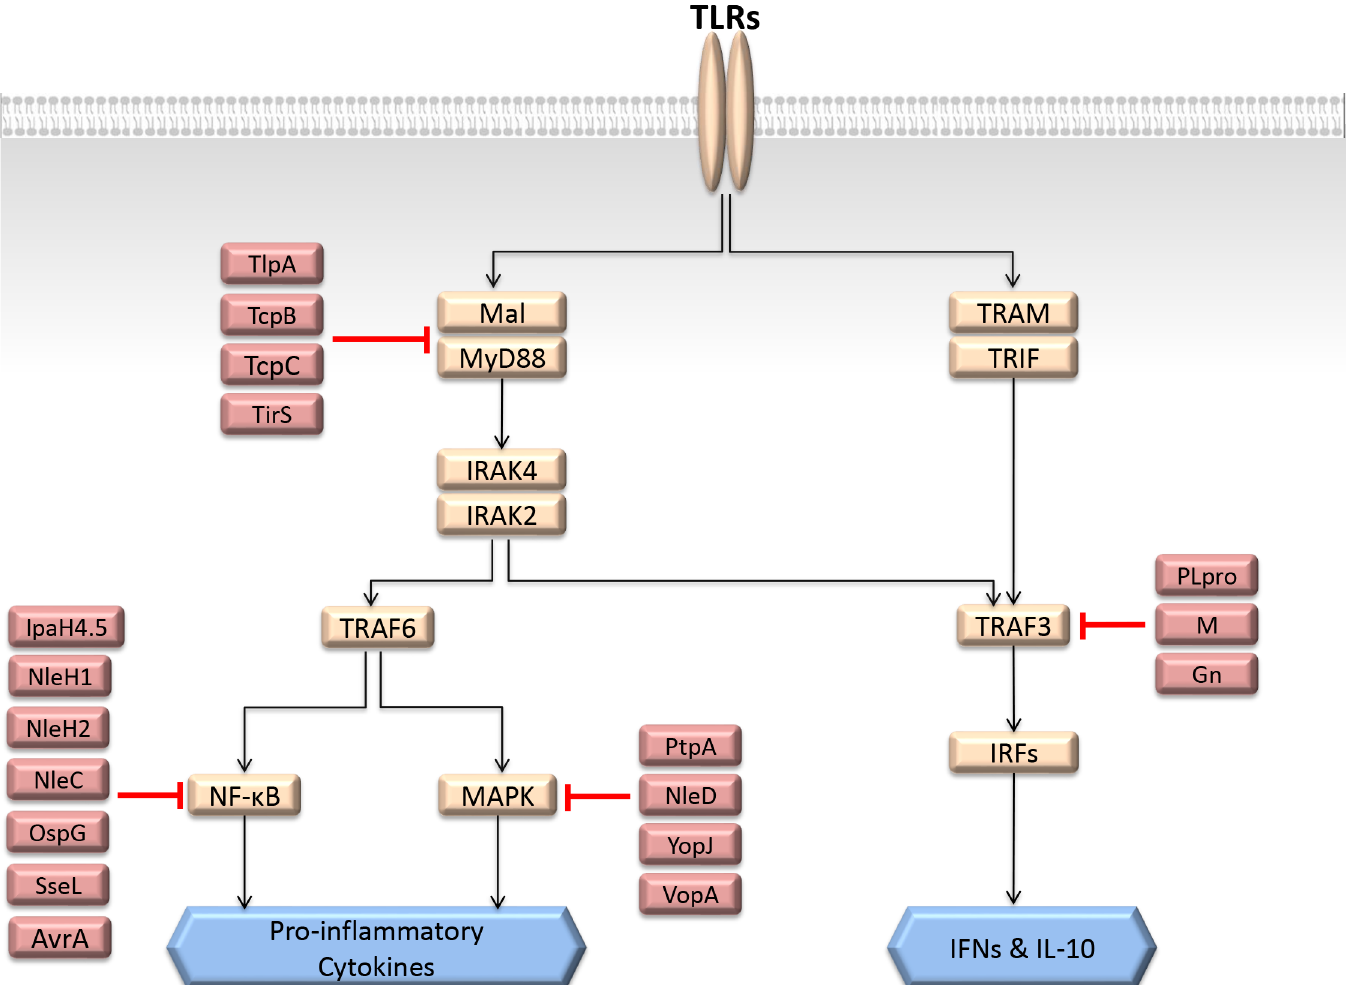
Fig 3. Subversion of TLR pathway by various bacterial and viral proteins at severalsteps. This is a simplifiedrepresentation of TLR pathway where the orangenodes are the host proteins and red nodesare the